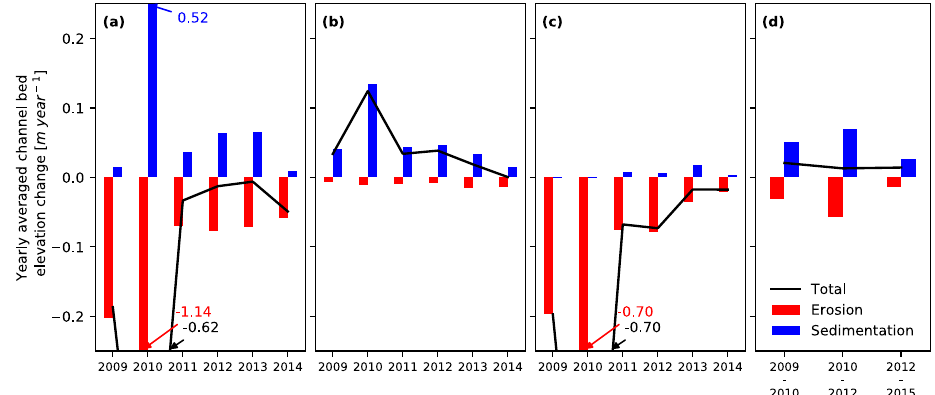
Figure 5. The yearly averaged channel section sedimentation (blue bars), erosion (red bars) and total change in height (black lines) for the inlet (a) , the center (b) , the outlet (c) and the entire study area (d) , which was opened 7 May 2008 and experienced a peak discharge event from 8 to 19 January 2011. Yearly averaged channel section sedimentation erosion and total change in height sedimentation rates for the entire area are only available for the periods 2009–2010, 2010–2012, and 2012–2015, since bathymetric measurements were only executed in all channels in 2009, 2010, 2012, and 2015; and in channel sections (see Fig. 1d) in 2011, 2013, and 2014.